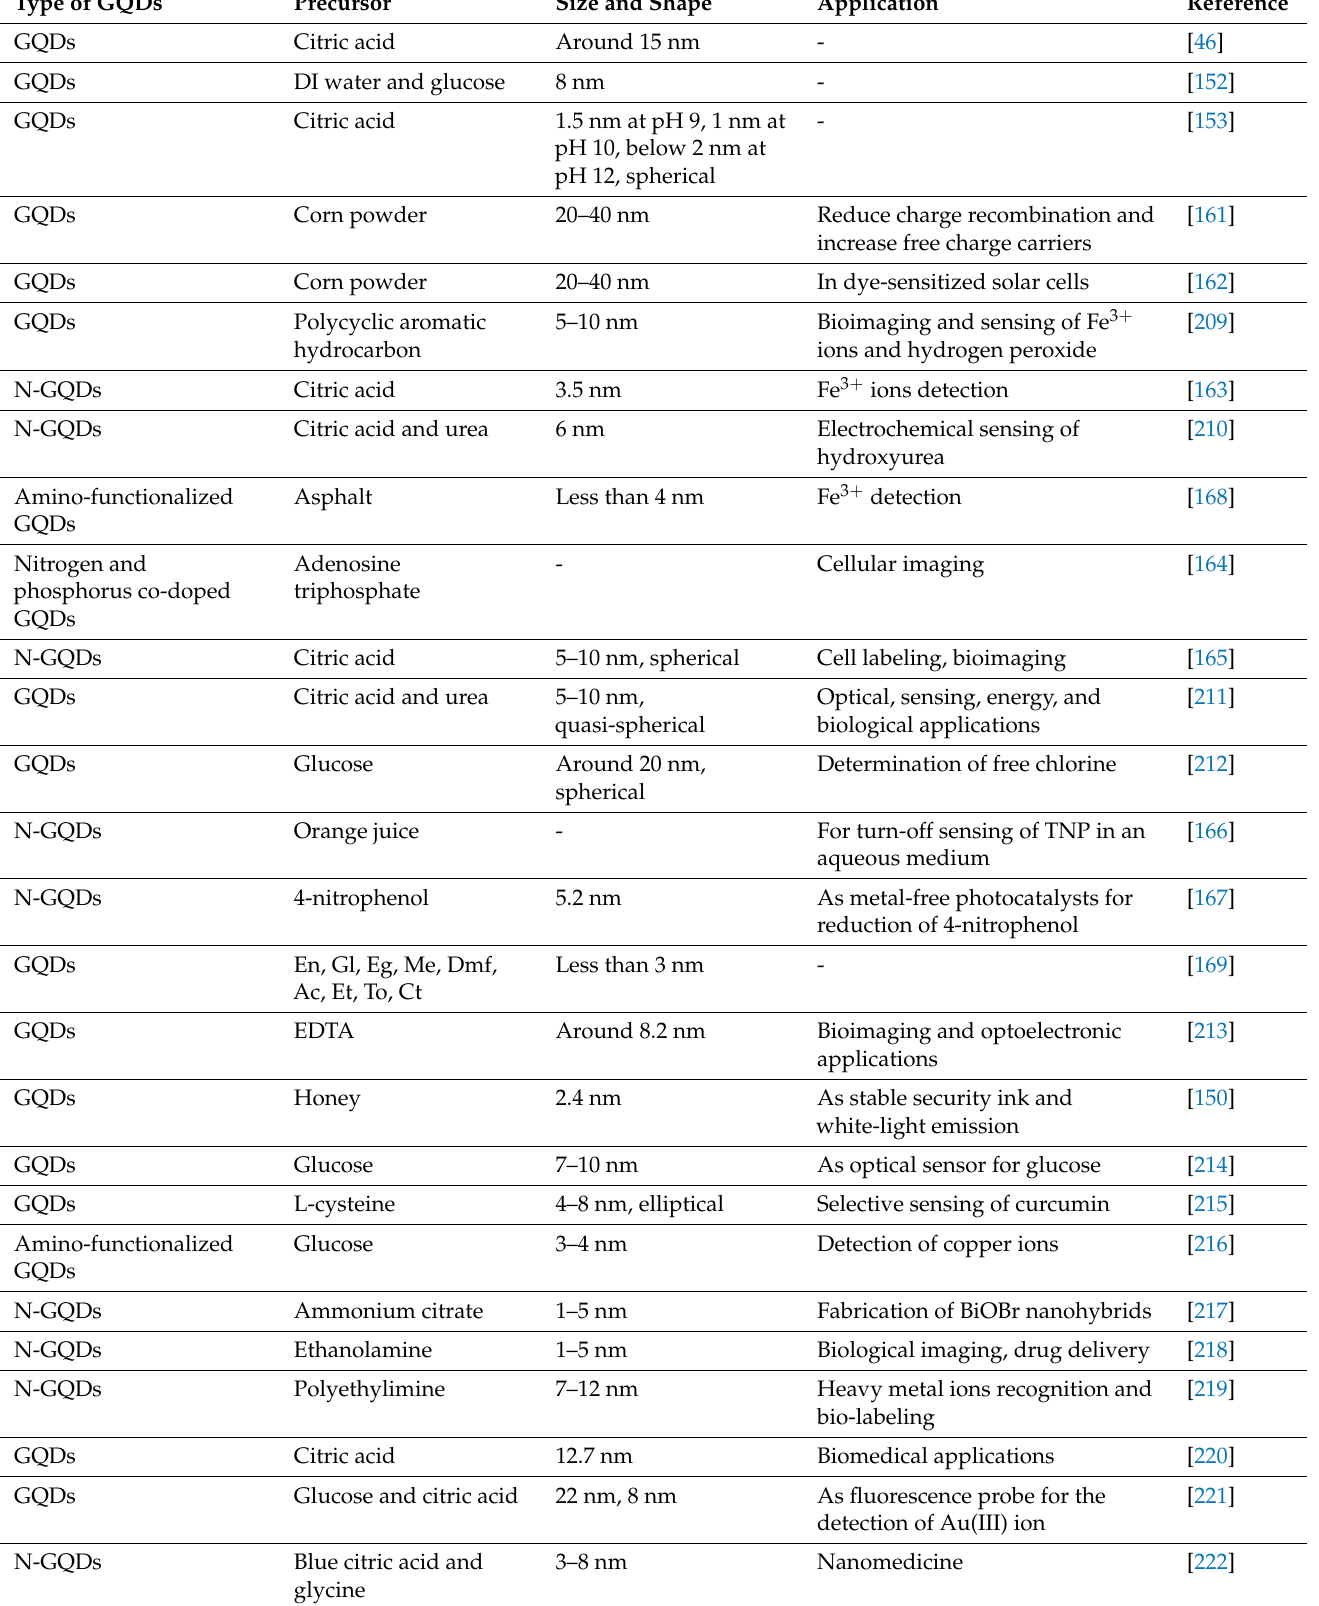
Table 2. The molecular carbonization methods for the preparation of